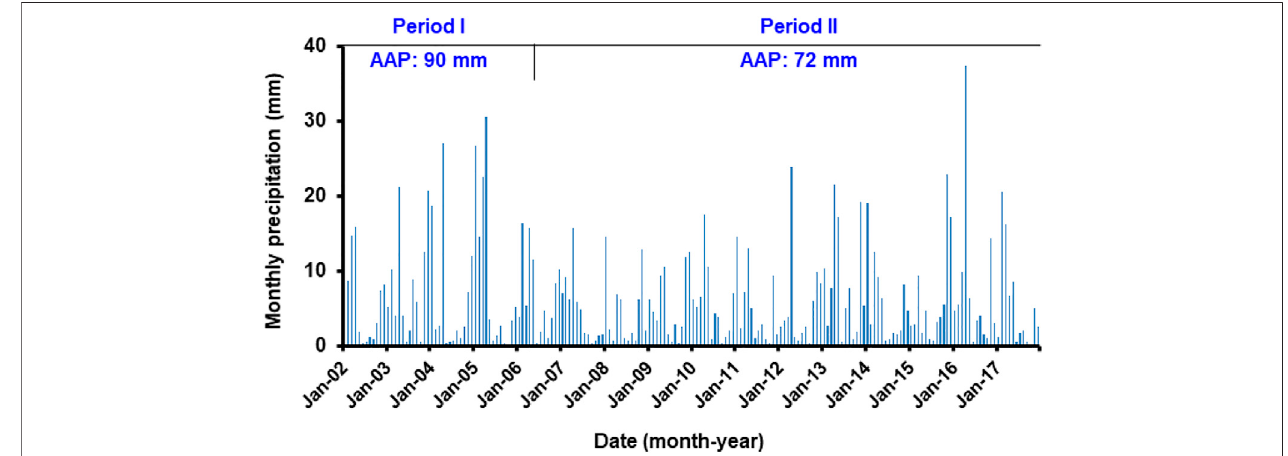
FIGURE 4 | Monthly precipitation (mm) across the Saudi Arabia throughout the two periods.